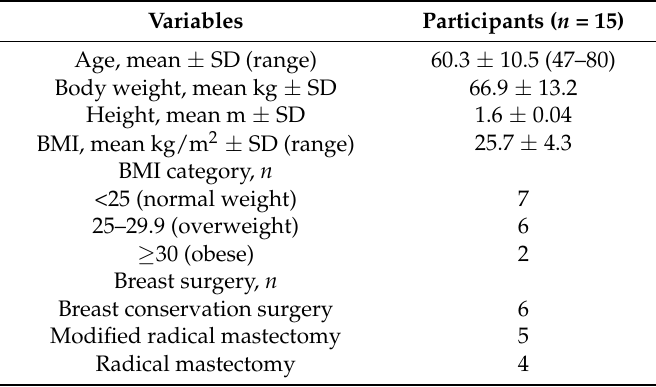
Table 1. Baseline characteristics of study participants ( n =